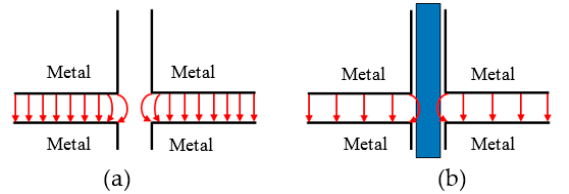
Figure 10. Schematic diagram of the electric field lines near the sample when ( a ) the cavity is empty; and ( b ) when there is a water-filled tube.